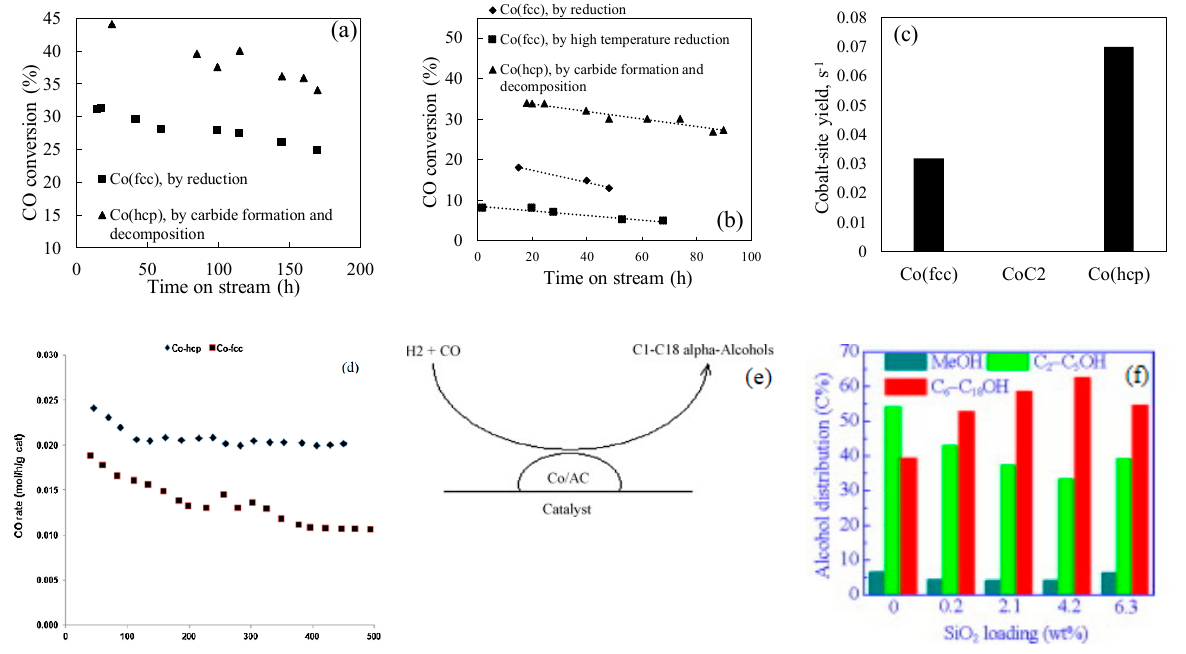
Figure 3. ( a ) FT activity of Co/Al 2 O 3 catalyst (from [19]), ( b ) FT activity of Co/SiO 2 catalyst (from [19]), ( c ) FT activity of Co/Al 2 O 3 catalyst (reproduced with permission from [21] Copyright 2011, Elsevier), ( d ) FT activity of Co/SiO 2 catalyst (reproduced with permission from [22] Copyright 2013, Elsevier). ( e ) C 1 –C 18 alcohols formation on Co/AC catalyst (reproduced with permission from [28] Copyright 2009, Elsevier), ( f ) C 1 -C 18 alcohols formation on Co/AC catalyst (reproduced with permission from [29] Copyright 2015,